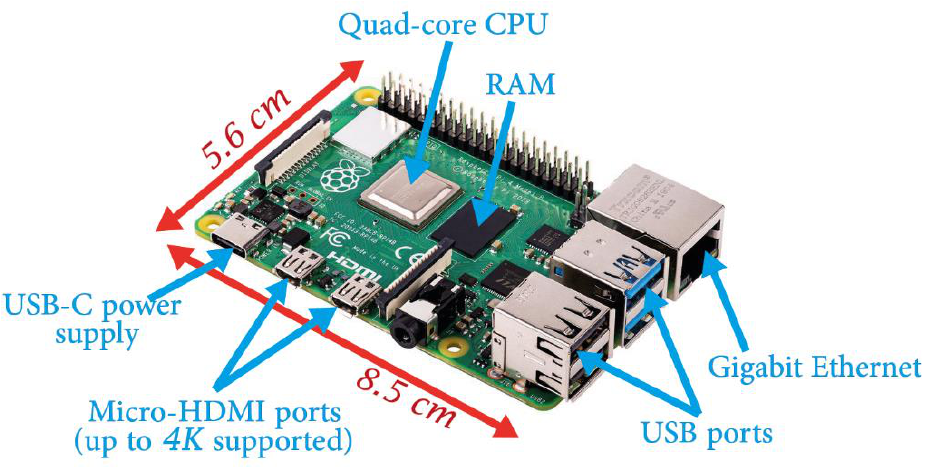
Figure 14. The hardware design of Raspberry Pi 4 model B that was used in our work.